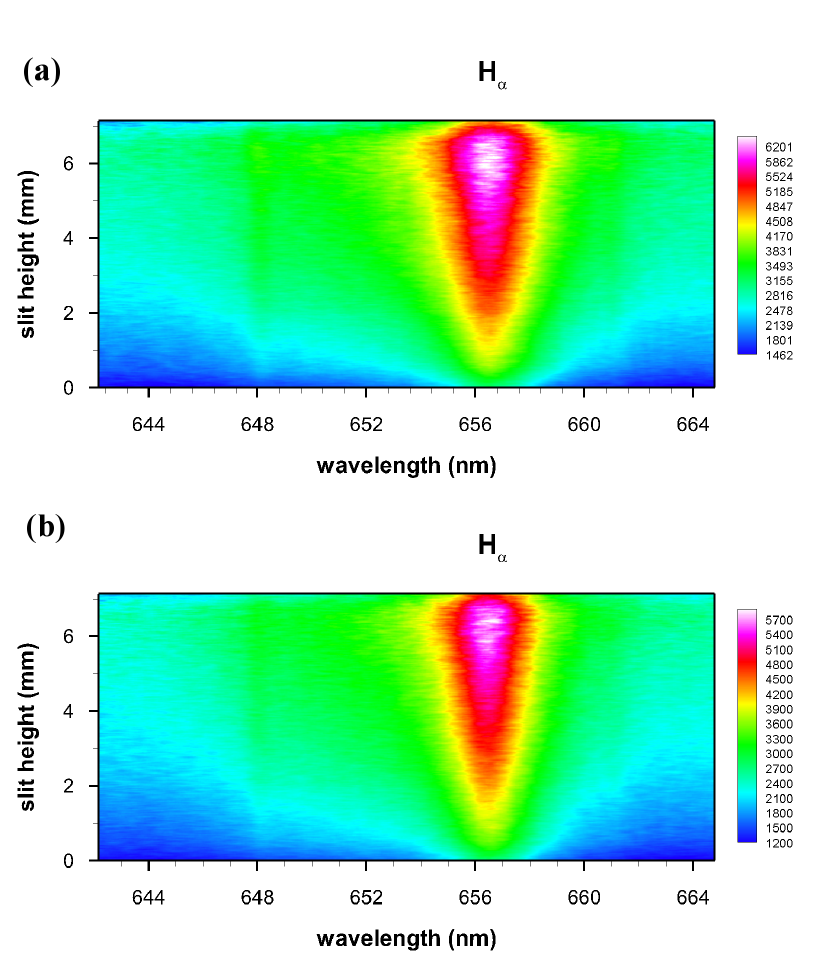
Figure 9. Time delay: ( a ) 700 ns; and ( b ) 800 ns. The nitrogen lines are hardly discernible in the expanding micro-plasma. Reproduced from Ref. [31] with